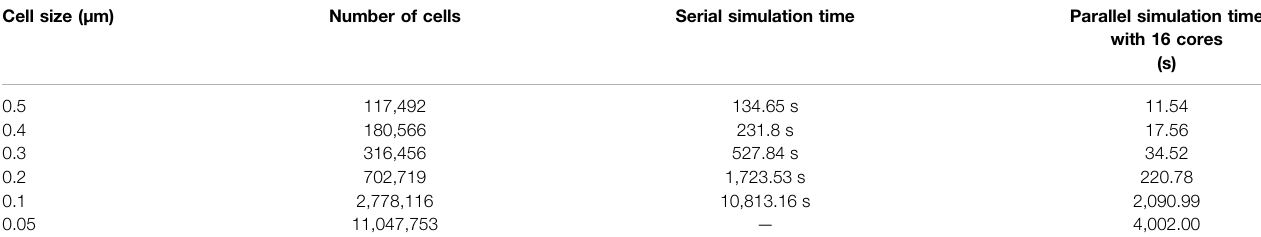
TABLE 3 | Simulation times for 1,000 iterations of the transverse case with 45% fi ber volume fraction at different cell sizes. Cell size (µm)